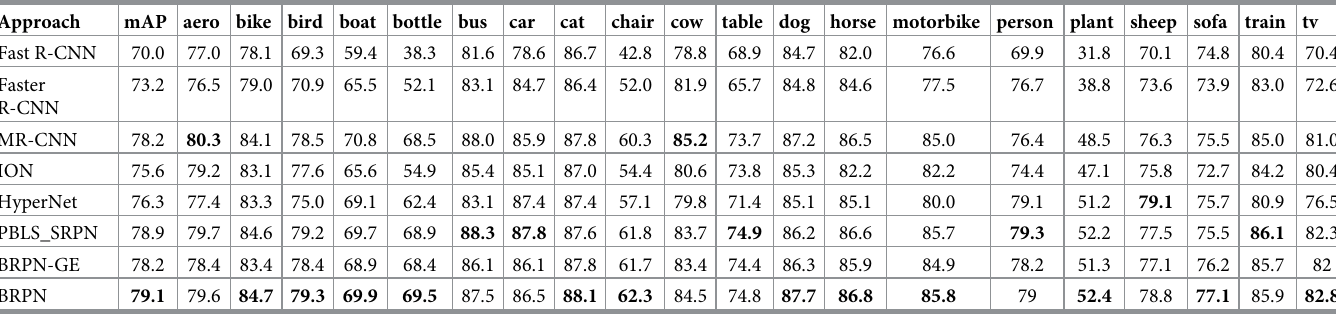
The best AP of each object category and mAP are highlighted in